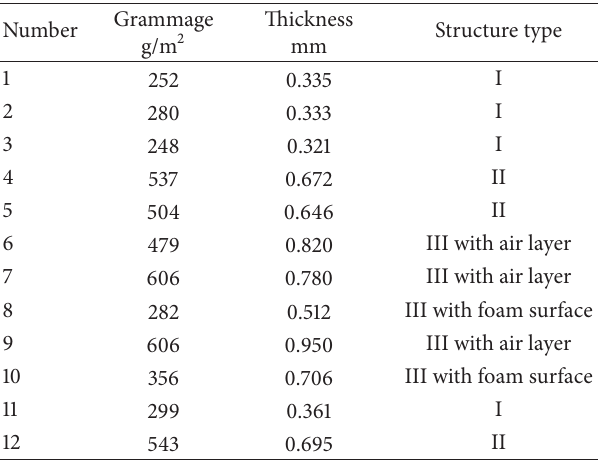
Table 1: Data of the paper cup